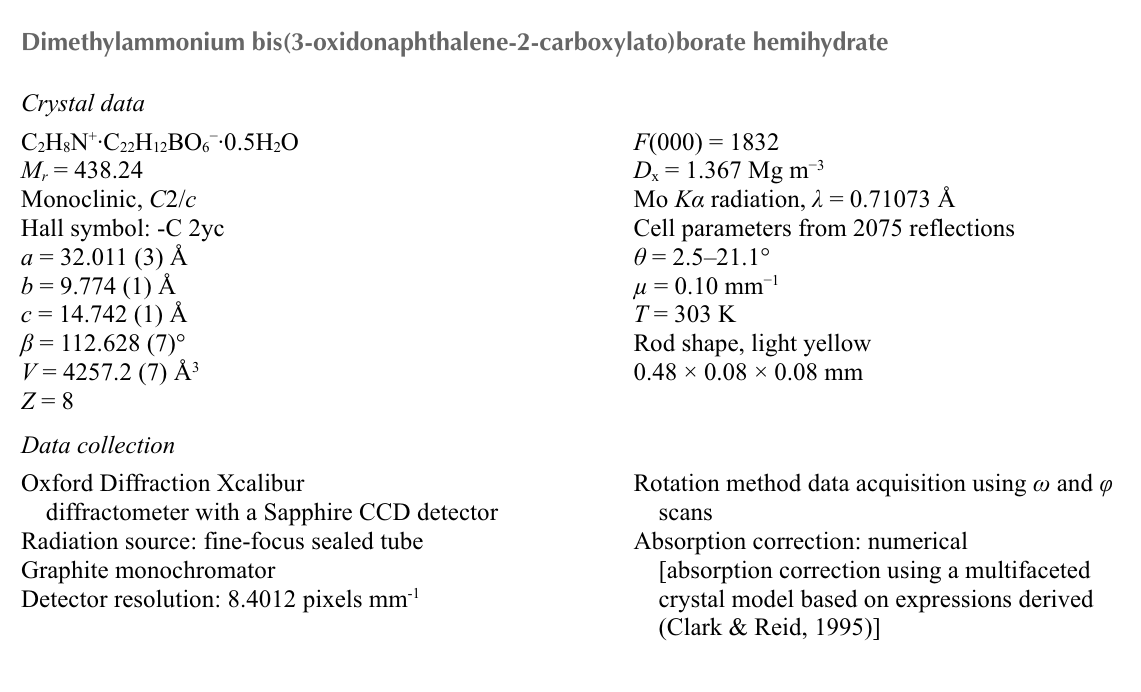
Figure 2 Hydrogen bond labelling scheme for (I). Dashed lines indicate hydrogen bonds. Some hydrogen atoms were omited for clarity). [Symmetry codes: (i): x , - y + 1, z - 1/2, (ii): x , y + 1, z , (iii):- x , - y + 1, - z +